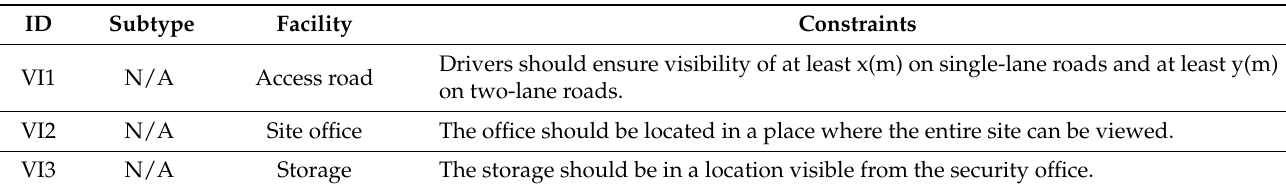
Table 6. Visibility constraints identified in this